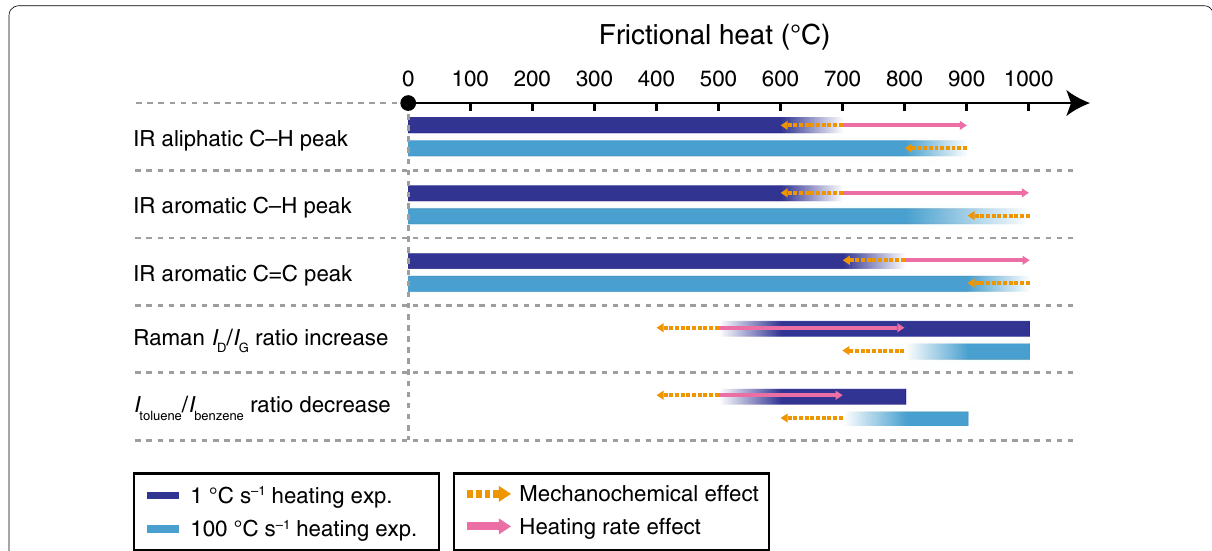
Fig. 7 Summary of organochemical reactions of CM as a function of temperature. Quantitative data on the mechanochemical effect on reaction temperature are from Kaneki et al. (2018), who reported that the mechanochemical effect can cause CM maturation reactions to occur at tempera- tures approximately 100 °C lower under a normal stress of 3 MPa and a slip distance of 10 m. exp .